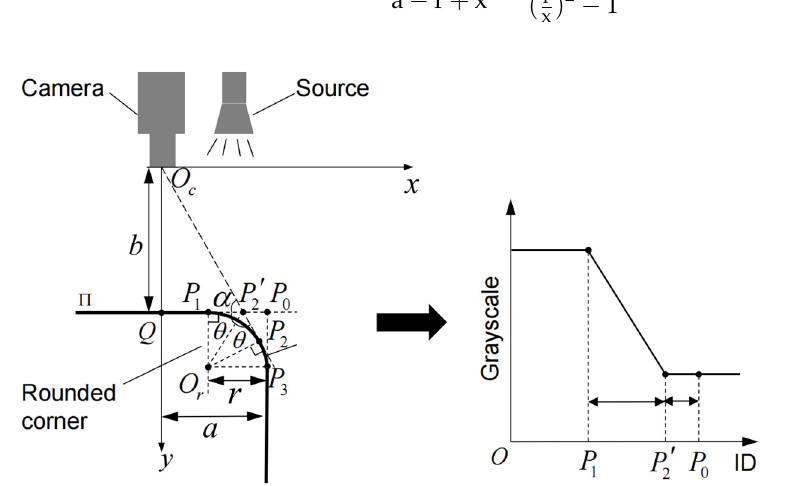
Figure 7. Schematic diagram of weakly illumination edge model.